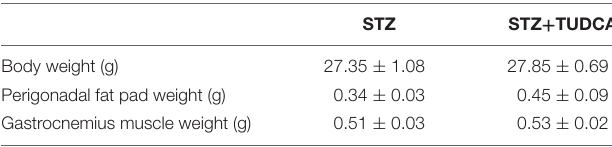
TABLE 1 | Final characterization of STZ and STZ + TUDCA mice (Student’s t -test was used for body weight; Mann-Whitney test was adopted for the other parameters, P ≤